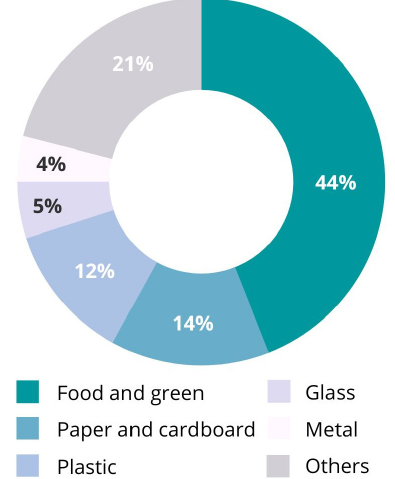
Figure 1. Global waste composition, by weight [2].